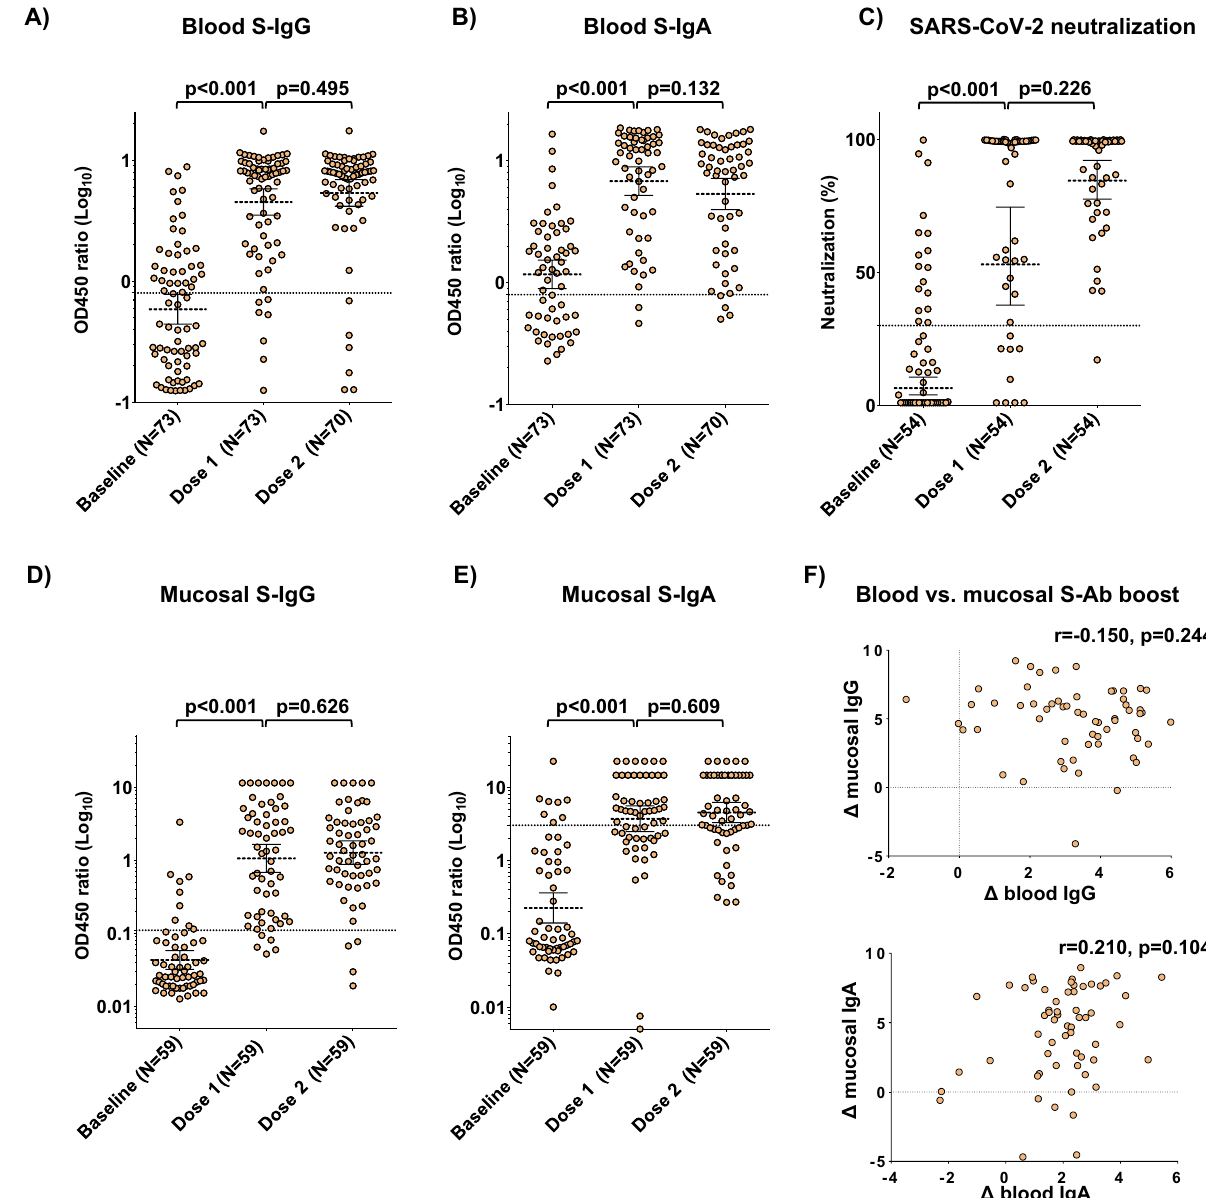
Figure 3. Effects of Sputnik-V vaccination on blood and mucosal SARS-CoV-2 antibodies in all participants. ( A ) Blood Spike-reactive IgG titers at baseline and after vaccination. ( B ) Blood Spike-reactive IgA titers at baseline and after vaccination. ( C ) SARS-CoV-2 neutralization at baseline and after vaccination. ( D ) Mucosal Spike-reactive IgG titers at baseline and after vaccination. ( E ) Mucosal Spike-reactive IgA titers at baseline and after vaccination. ( F ) Correlation plots of mucosal and blood IgG (top) and IgA (bottom) log2-transformed post-dose 2/baseline titer ratios (denoted by “ Δ ”). The Spearman coefficients (r) and their statistical significance (p) are shown. In panels A-E: brackets represent geometric means and 95% confidence intervals; p values indicate the statistical significance assessed by the Mann–Whitney U test. In panels A–E: dotted lines represent the thresholds of assay positivity, defined as OD450 ratio = 0.8 for blood S-IgG and S-IgA, SARS-CoV-2 neutralization = 30% and OD450 ratio = 0.11 and 3.03 for mucosal S-IgG and S-IgA,